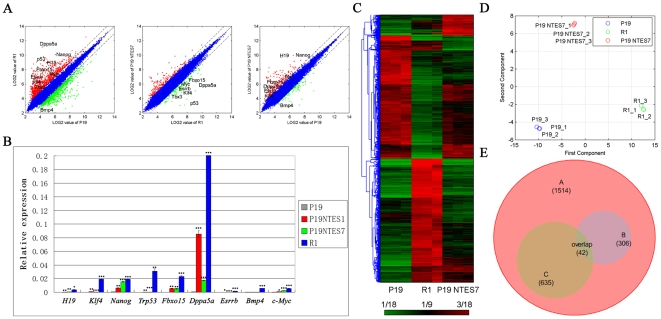
Molecular characteristics of P19 NTES cells.Scatter plot analysis was performed to compare the global gene expression profiles among different groups; hierarchical clustering and overlapping were further carried out to sort and analyze the differentially expressed genes. (A) Scatter plot analysis of the differentially expressed probe sets among P19 cells, P19 NTES cells and R1. Blue dots represent the unchanged probe sets; red dots represent the up-regulated probe sets; green dots represent the down-regulated probe sets. (B) Verification of the expression of several important genes undergoing dramatic changes by quantitative PCR. Error bars depict standard deviation. * p-value <0.05; ** p-value <0.01; *** p-value <0.001 (C) Unsupervised hierarchical clustering of averaged global transcriptional profiles obtained from P19 cells, P19 NTES cells and R1. (D) PCA. (E) Overlapping analysis of GeneSets A, B, and C.